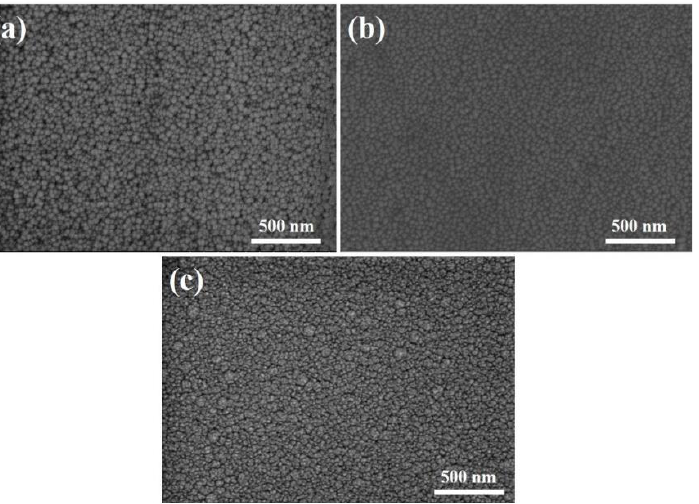
Figure 1. Top-surface SEM images of Ni/Ni 3 Al-MoW multilayer with varying h: ( a ) 160 nm; ( b ) 40 nm; ( c ) 10 nm. ( b ) 40 nm; ( c ) 10